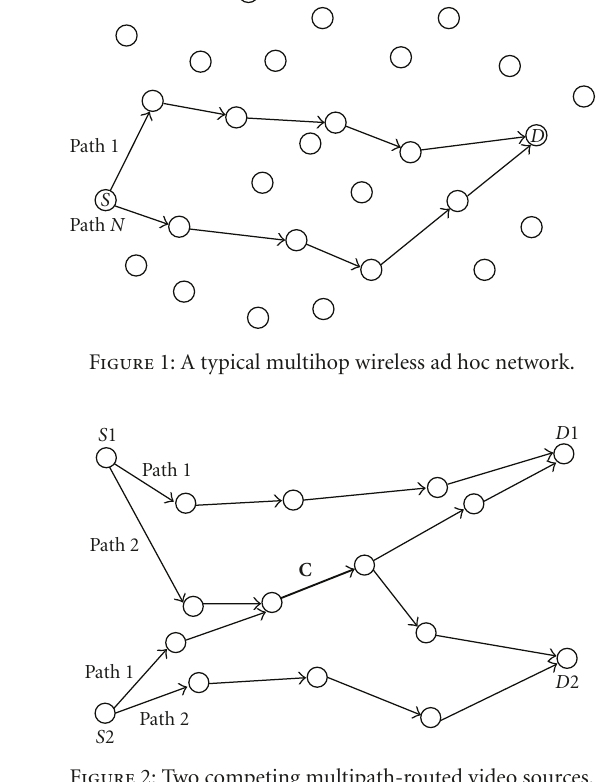
Figure 2: Two competing multipath-routed video